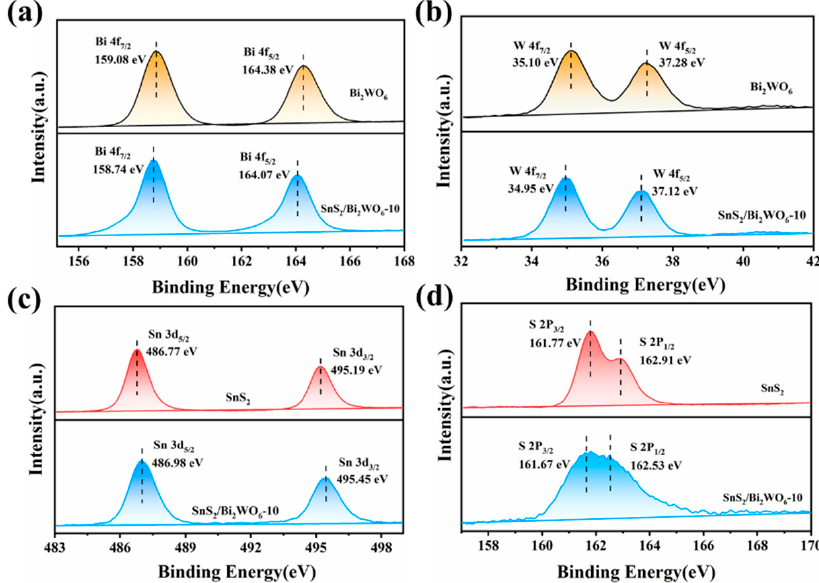
Figure 4. High-resolution XPS spectra of ( a ) Bi 4f, ( b ) W 4f, ( c ) Sn 3d, and ( d ) S 2p.